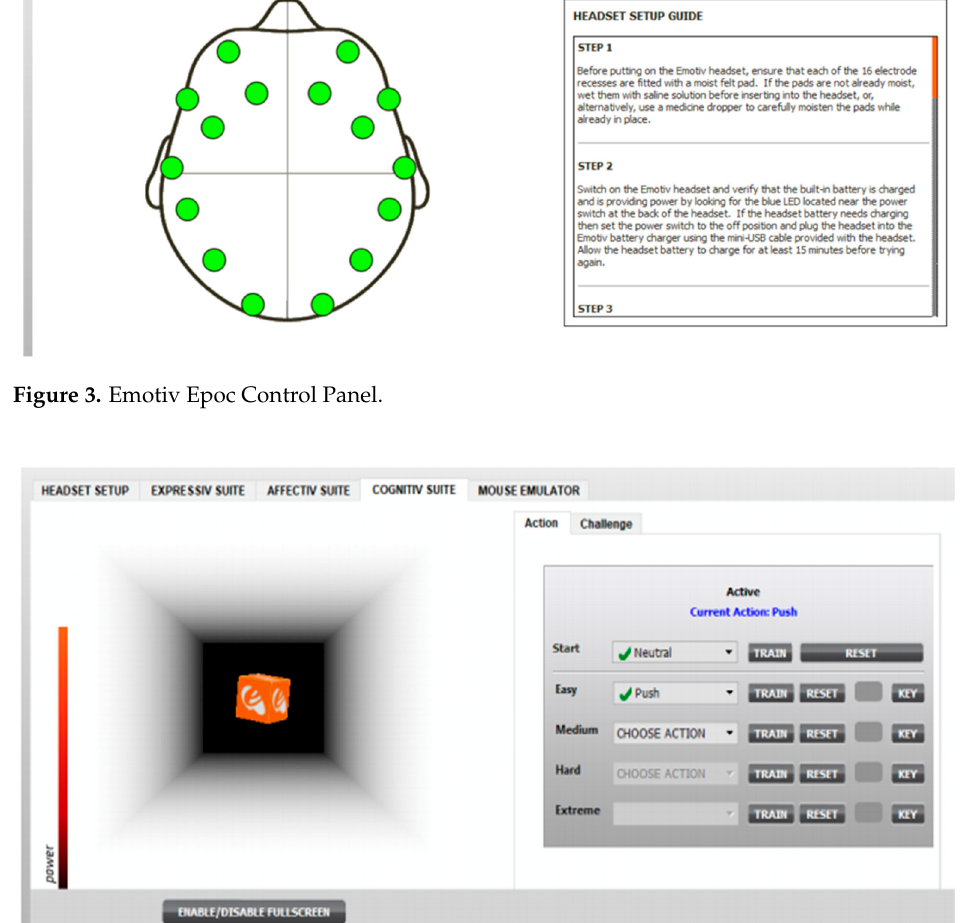
Figure 4. Emotiv Epoc Control Panel with Cognitive Suite Tab.